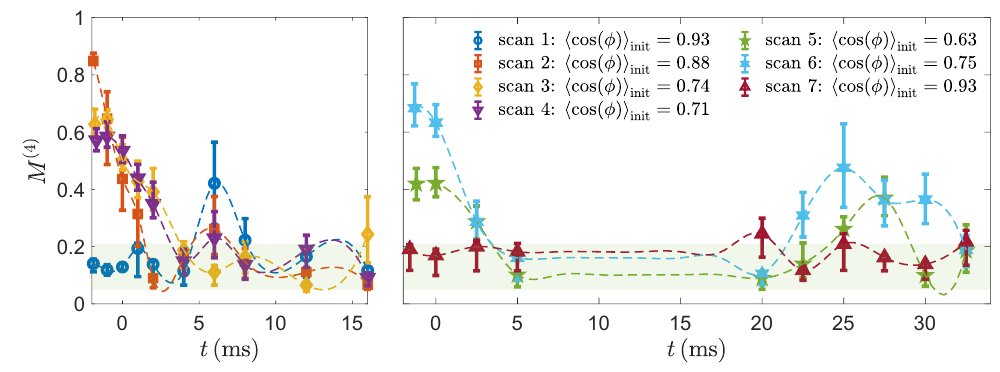
Figure 3: Observation of Gaussification ( left ) and the recurrence of non-Gaussianity ( right ) in the experiment. Plots of the non-Gaussianity measure M ( 4 ) as a function of time in various experimental scans corresponding to different initial states, as presented in Ref. [ 24 ] (the plots are based on the data published in Ref. [ 36 ] ). The time window ranges from the initial time until 16 ms (left) or 32.5 ms (right) . Notice that the decay of non-Gaussianity follows a relatively sharp decrease to a small saturation value. At the recurrence time [ 30 ] the non-Gaussianity returns to quite a high value relative to the initial one. The green shaded area indicates the bias values of M ( 4 ) corresponding to Gaussian states with finite